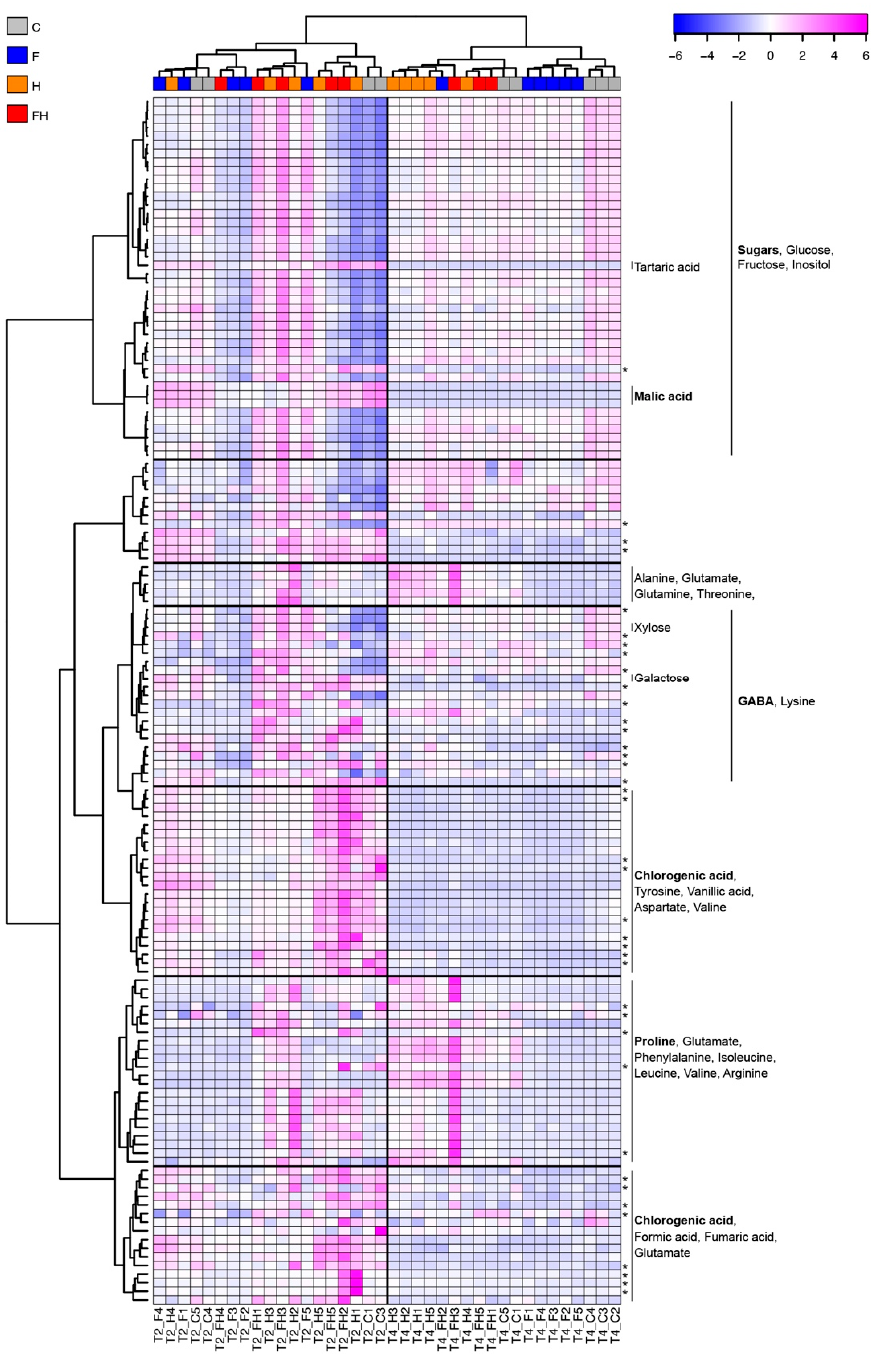
Figure 10. Heatmap of the signal area values of compounds quantified through NMR in T2 and T4 samples. The different replicates were marked at the top of the heatmap with different colors according to the sample to which they belong (a legend is provided at the top left), while the scale of the heatmap values is shown at the top right. Samples are named according to the timepoint, the treatment (C, control; F, flooded; H, heatwave; FH, flooded plus heatwave), and the replicate. (*, Unknown